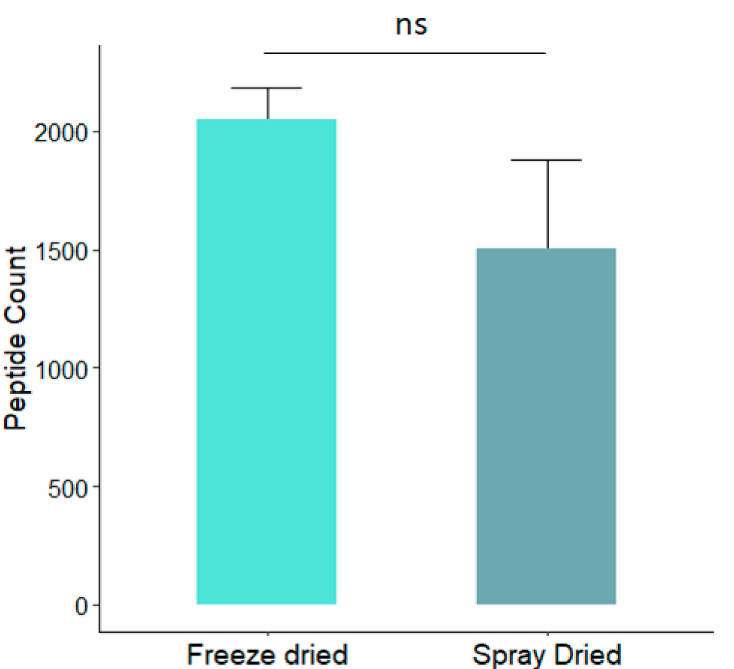
Figure 1. Effect of FD and SD on peptide count of rice NPN. The peptide counts as determined by LC-MS/MS in a bar chart representation of rice NPN FD (teal) and SD (blue) samples. Data represented at mean ± STD. Analysis was carried out using a Student’s t test; ns, not significant; p =